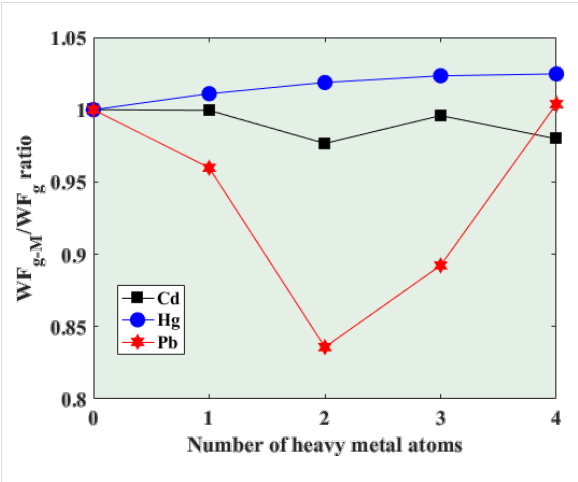
Figure 11: Dependence of the sensitive parameter (ratio of work func- tions of graphene before and after interaction with heavy metals) on the number of heavy metal